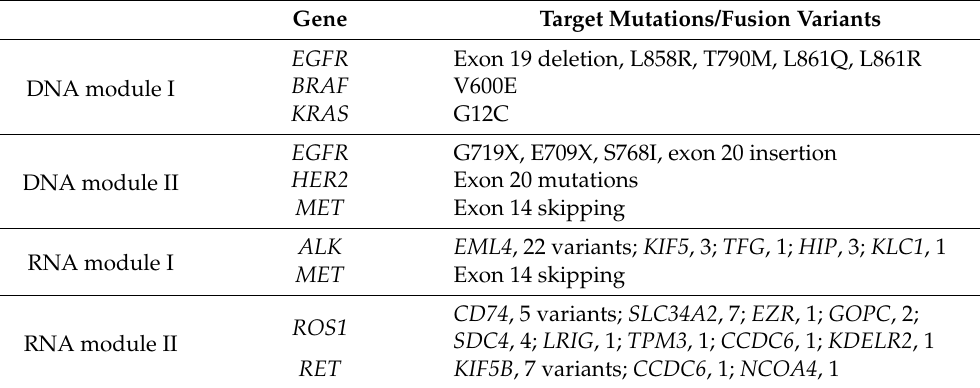
Table 1. Modules of the compact panel.